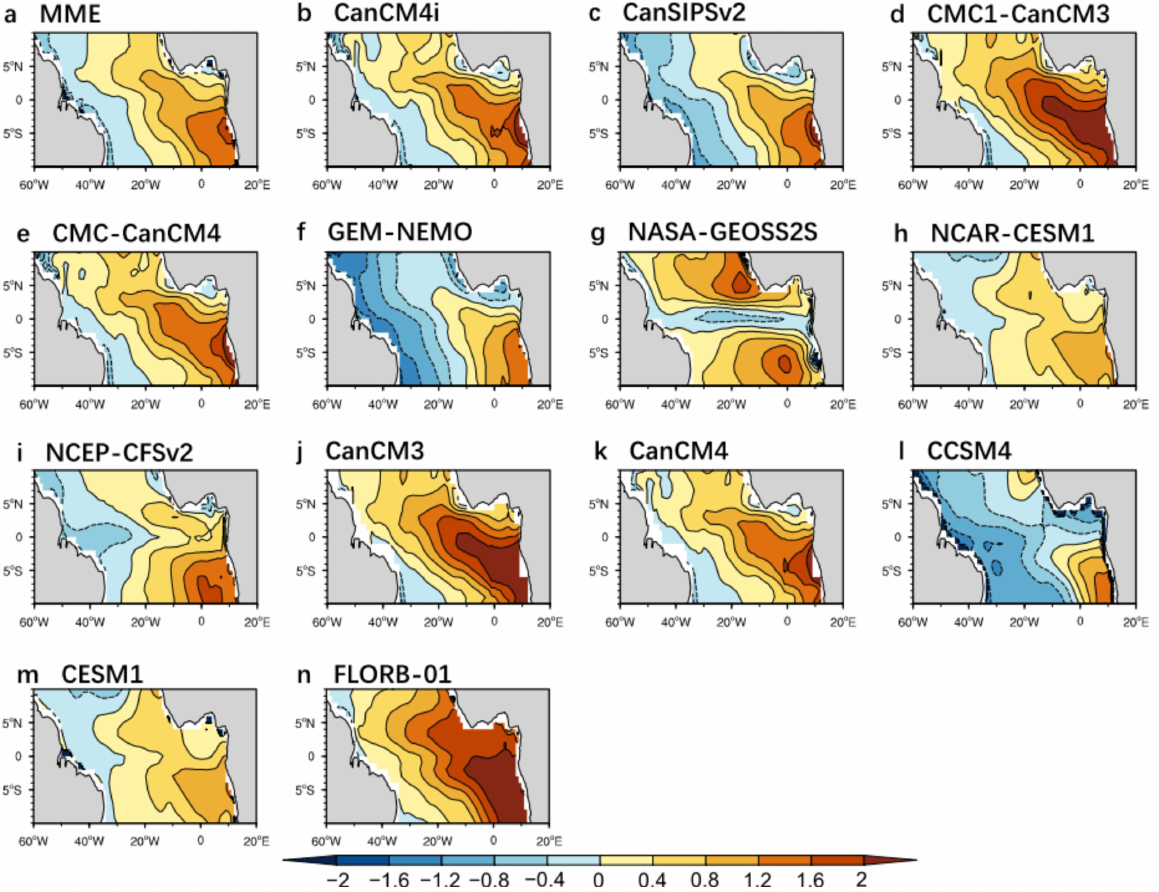
Figure 9. The biases of the predicted mean SST for ( a ) MME and ( b – n ) the individual models. The mean SST biases shown here are derived from the four-month-lead forecasts, which resemble those at different lead times. In general, the mean state biases have the similar spatial pattern for different lead time forecasts except that the magnitude of the biases increases with the increasing lead